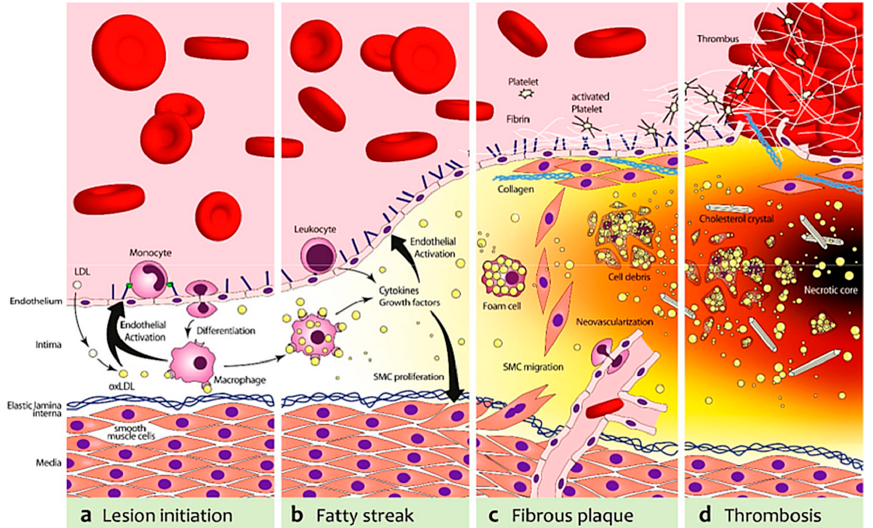
Figure 3. Schematic depiction of representative targets for molecular imaging of atherosclerosis and plaque vulnerability. ( a ) In the first stage, low-density lipoprotein cholesterol (LDL) is deposited